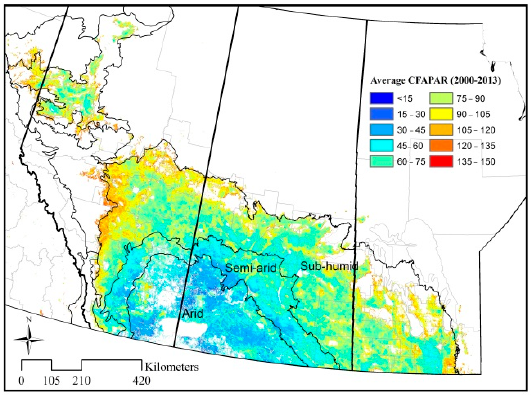
Figure 3. Spatial distribution of the average annual cumulative FAPAR (CFAPAR) during 2000 – 2013.